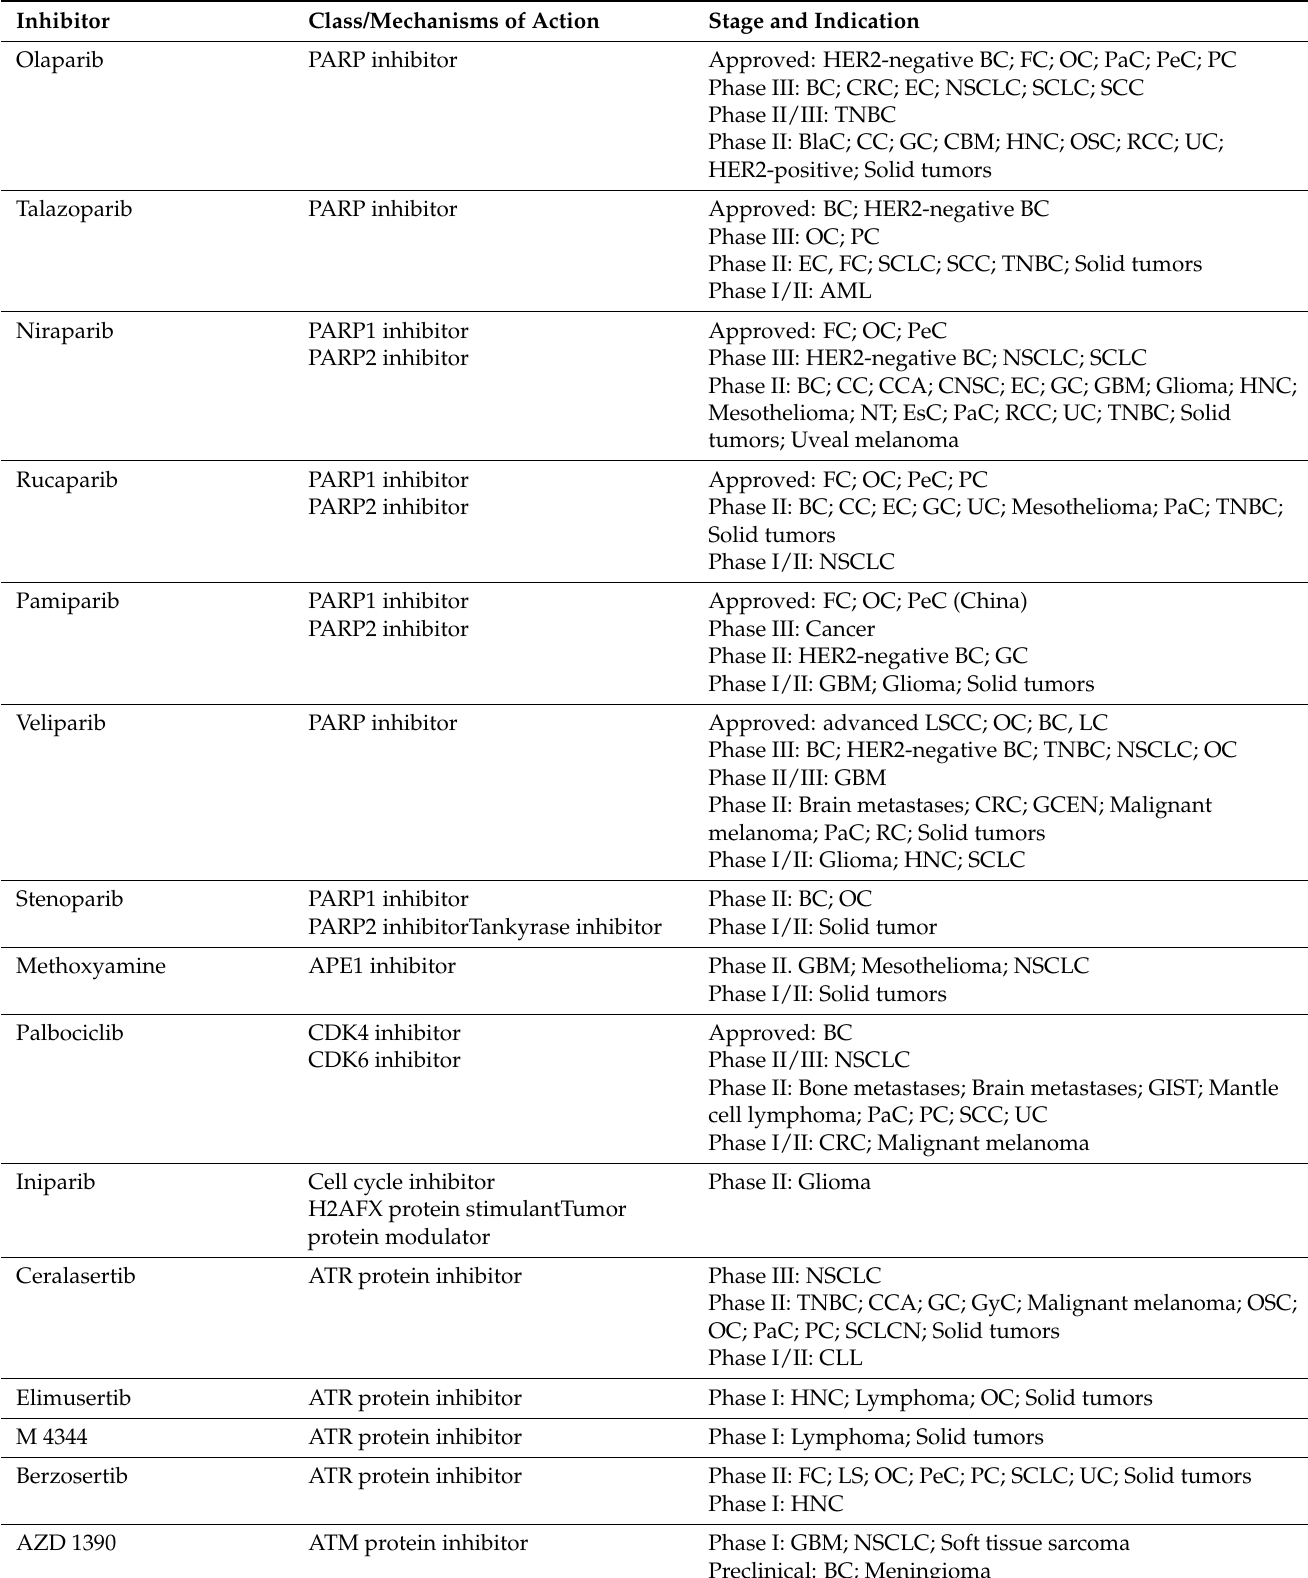
Table 1. Selected DNA damage response inhibitors approved and under